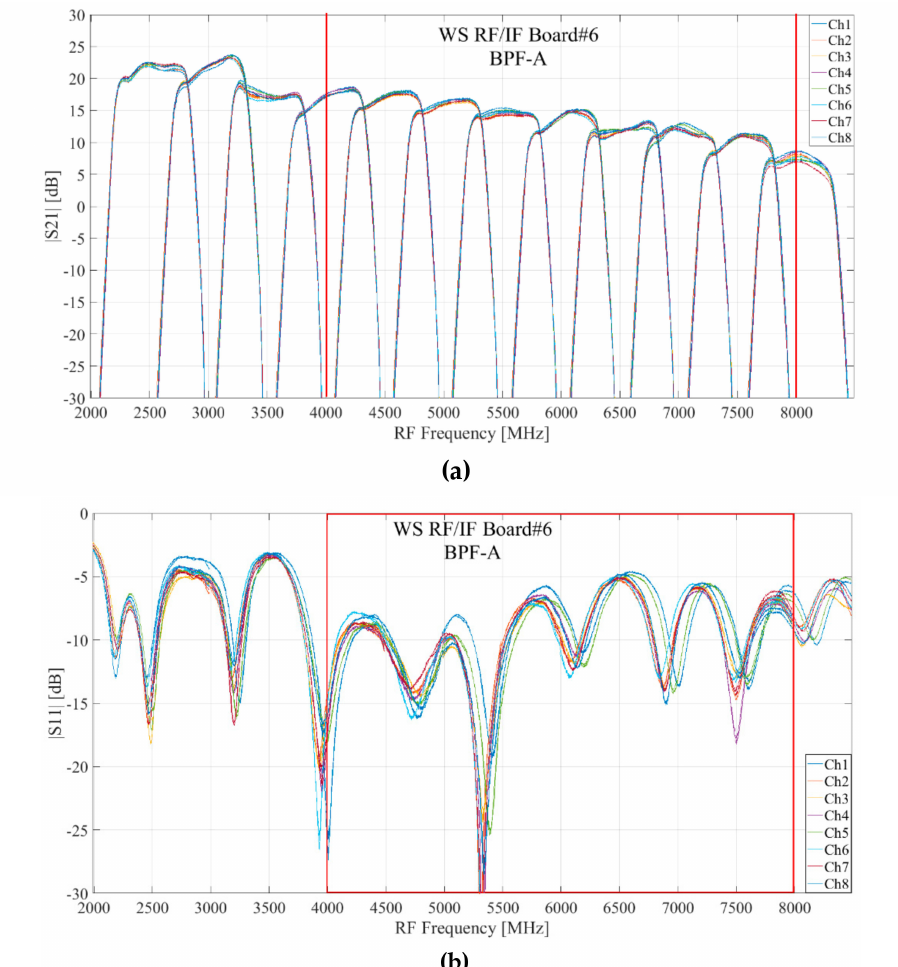
Figure 19. VNA test of the eight channels of board #6. Cumulated measures from 12 different LO frequency settings, from 3 GHz to 8.5 GHz by 0.5 GHz steps. The power level was set at − 5 dBm for the LO and − 30 dBm for the RF. The filter BPF-A was selected. ( a ) Lower side band (LSB) gain from SMA RF input connector to MCX IF output connector; ( b ) LSB signal reflection coefficient at SMA RF input